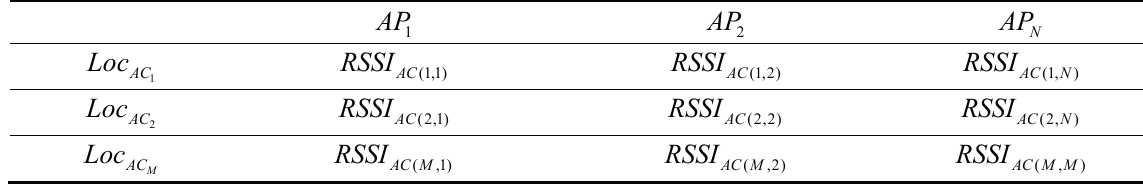
Table 2. Online RSSI Observation for each